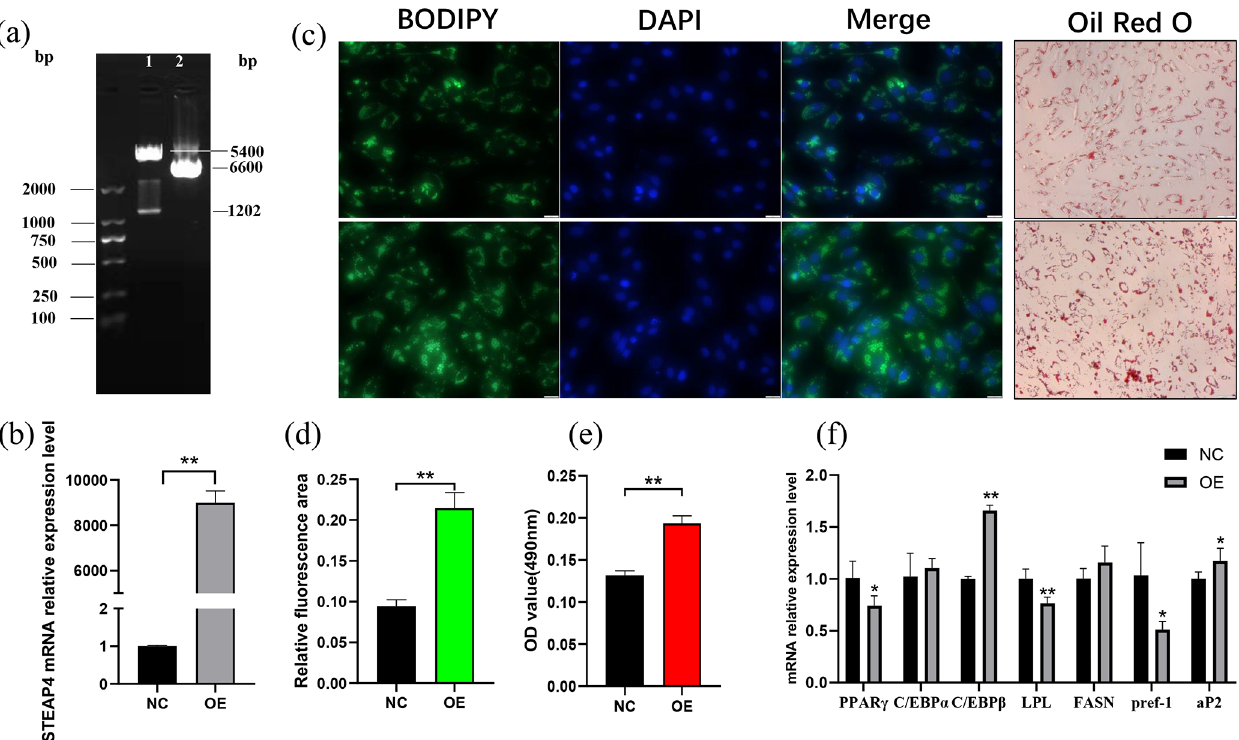
Figure 6. The effect of overexpression of goat STEAP4 on the differentiation of subcutaneous preadipocytes. (a) pcDNA-3.1- STEAP4 restriction digestion diagram. (b) Efficiency of STEAP4 overexpression. (c) Image of BODIPY and Oil Red O staining. (d) BODIPY fluores- cence quantification. (e) Oil Red O staining lipid droplet quantification. (f) Adipocytes differentiation-related gene expression. “ ∗∗ ” means P < 0 . 01, and “ ∗ ” means P < 0 .